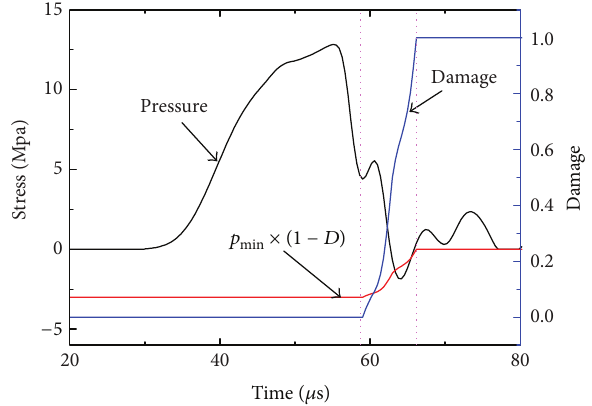
Figure 7: Pressure and damage versus time of target C.